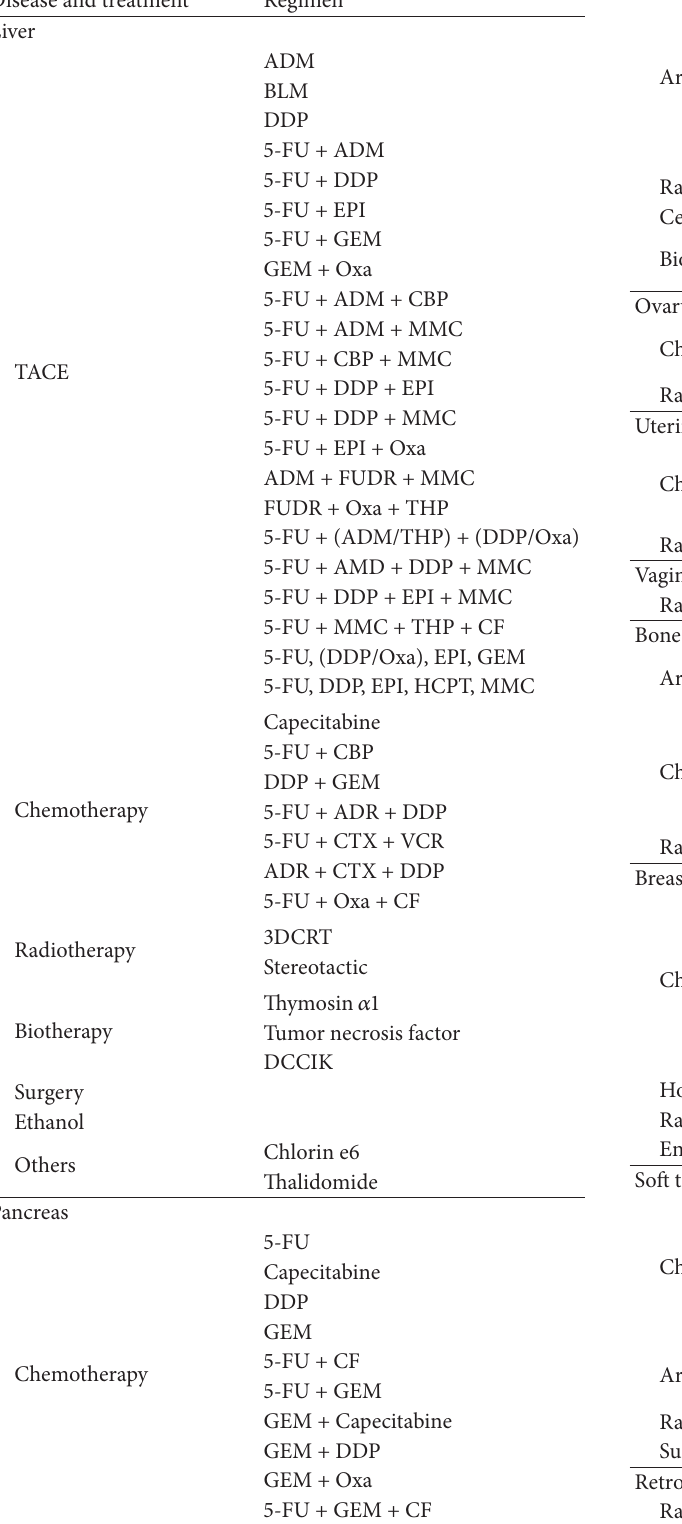
Table 1: List of the therapeutic strategies applied during HIFU for cancers.